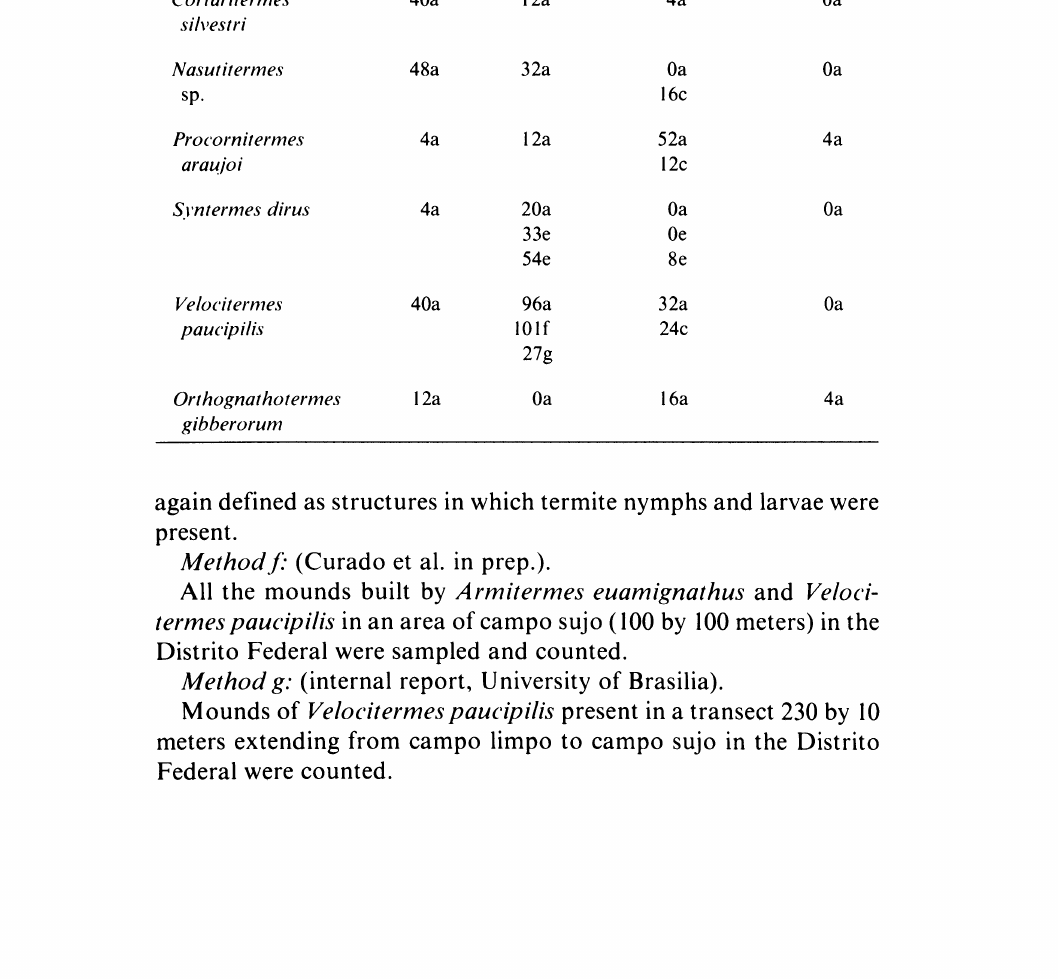
Table 6. Distribution and densities of termite nests/mounds per hectare in four vegetation types (Letters correspond to different sampling methods--see text for details). Campo Campo Cerrado Species Limpo Sujo Sensu Stricto Cerradao